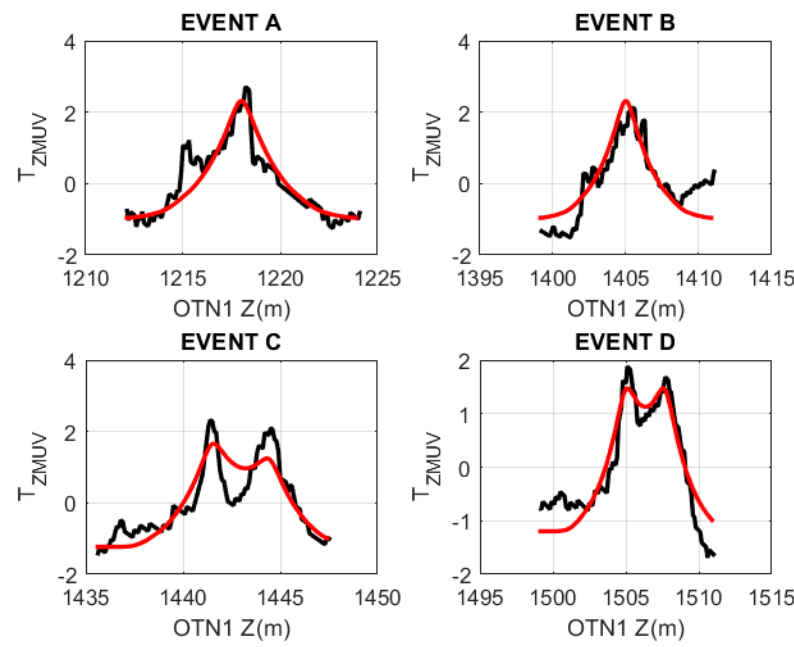
Figure 15. Following Figure 10, overlays of Figure 13 model wellbore axial temperature profiles (red traces) for 300 cm radius wellbore embedded in a 10-m radius crustal volume superposed on OTN1 wellbore temperature events A, B, C, and D (black traces). Horizontal axes give wellbore depth in meters; vertical axes are wellbore temperature profiles normalised to zero-mean/unit-variance. The favoured model flow channel thickness is 0.6 m, as illustrated in Figure 7. ( Upper Left ) Model temperature profile computed for single 0.6 m thick flow channel. ( Upper Right ) Model temperature profile for 2–3 m thick flow channel. ( Lower Left ) Model temperature profile for 4-m spaced pair of 0.6 m thick flow channels. ( Lower Right ) Model temperature profile for 3-m spaced pair of 0.6 m thick flow channels.